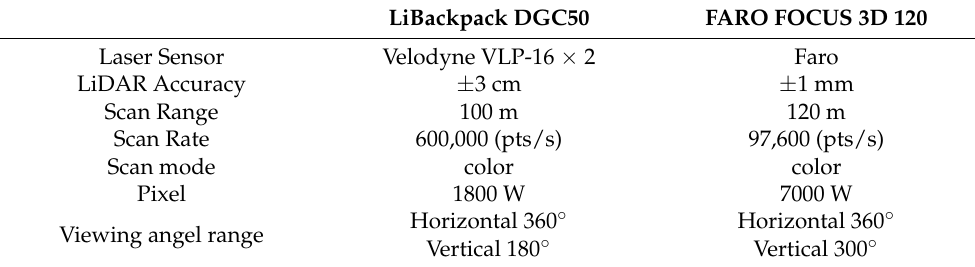
Table 2. Comparison of various parameters of the backpack LiDAR and